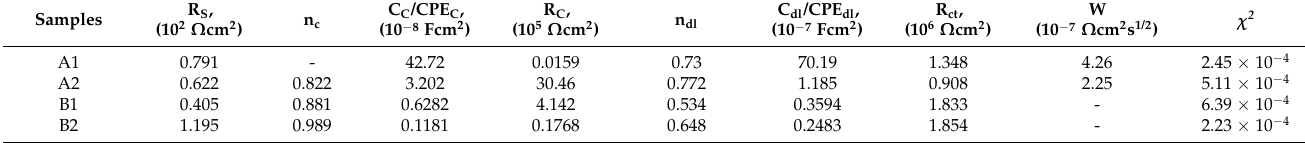
Figure 7. Representation of CNLS simulated and experimental data for each sample after 24 h in 3% NaCl solution with Nyquist and Bode plots. Nyquist diagrams are represented in ( a ) A1, ( c ) A2, ( e ) B1 and ( g ) B2, while Bode and Phase ‐ angle plots are shown in ( b ) A1, ( d ) A2, ( f ) B1 and ( h ) B2.